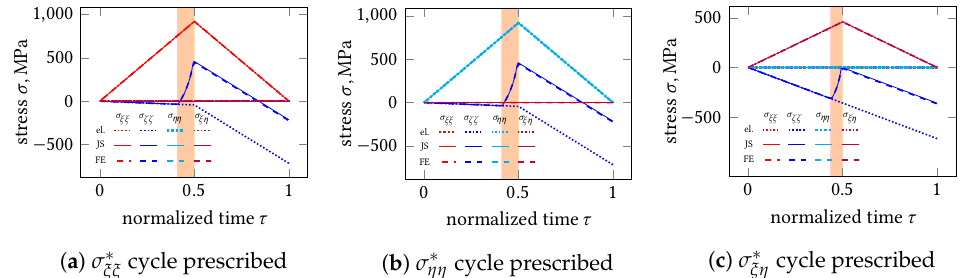
Figure 6. Transient stresses computed by FE analysis vs. the JS method and the prescribed elastic input (labeled “el.” and drawn using dotted lines). The highlighted subinterval of τ represents the domain where plasticity occurred.